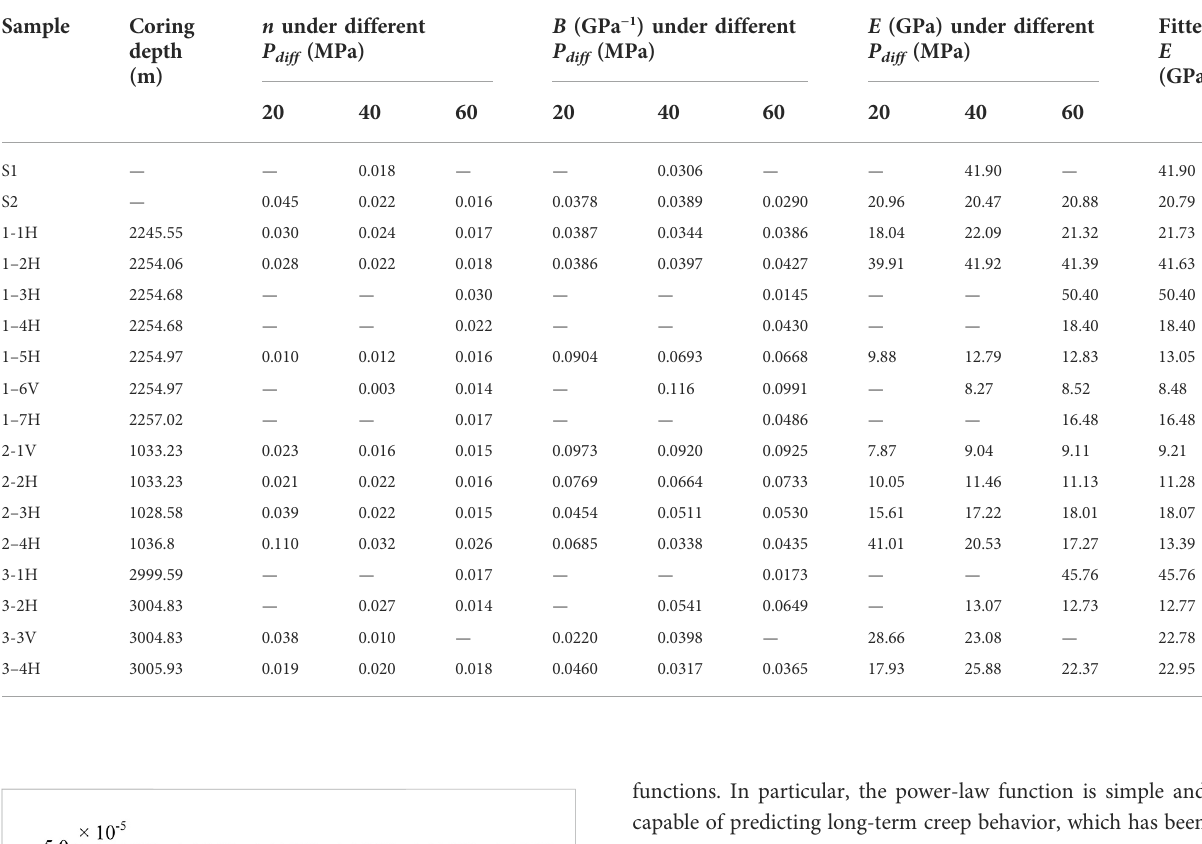
TABLE 2 Power-law constitutive parameters for Longmaxi shale sample.